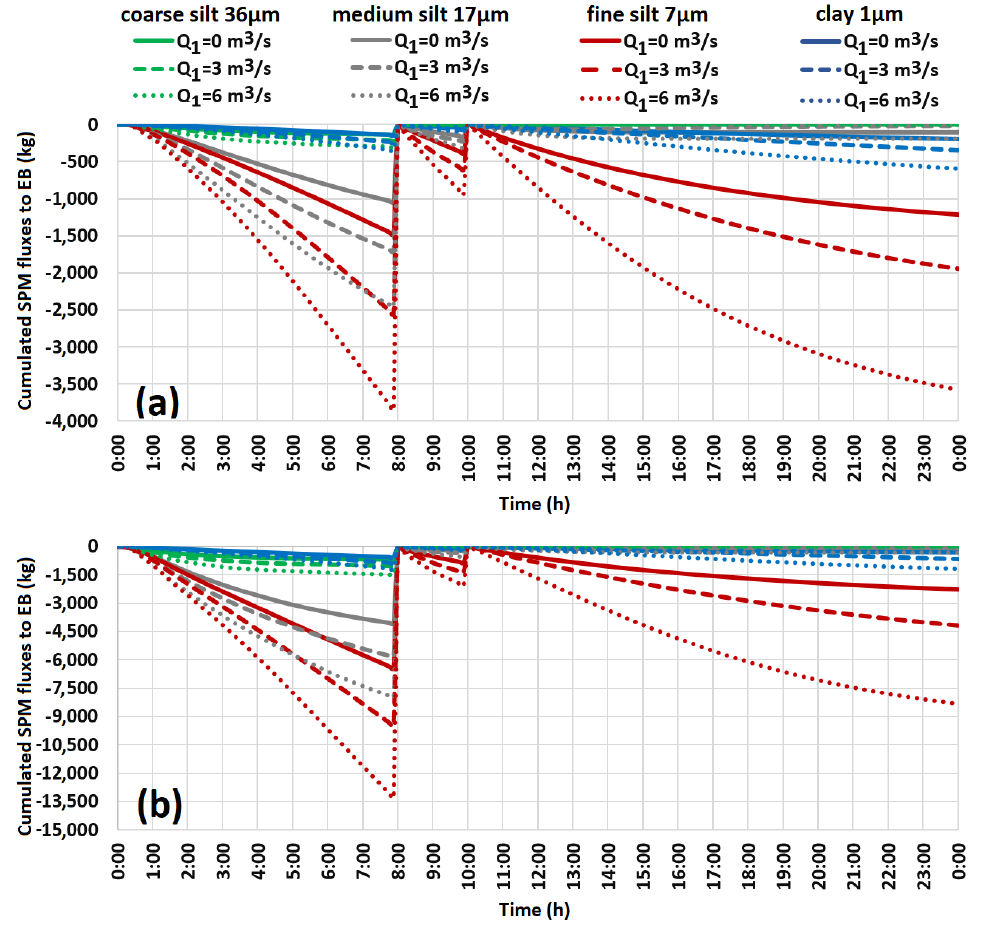
Figure 13. Cumulative fluxes to EB (kg) of clay and silt suspended sediments during each 24 h scenarios, for the three values of Q 1 and the wind speed of 15 m/s; ( a ) N-NW wind; ( b ) S-SE wind. The fine fraction of the sediments preferentially fixes the contamination [2].